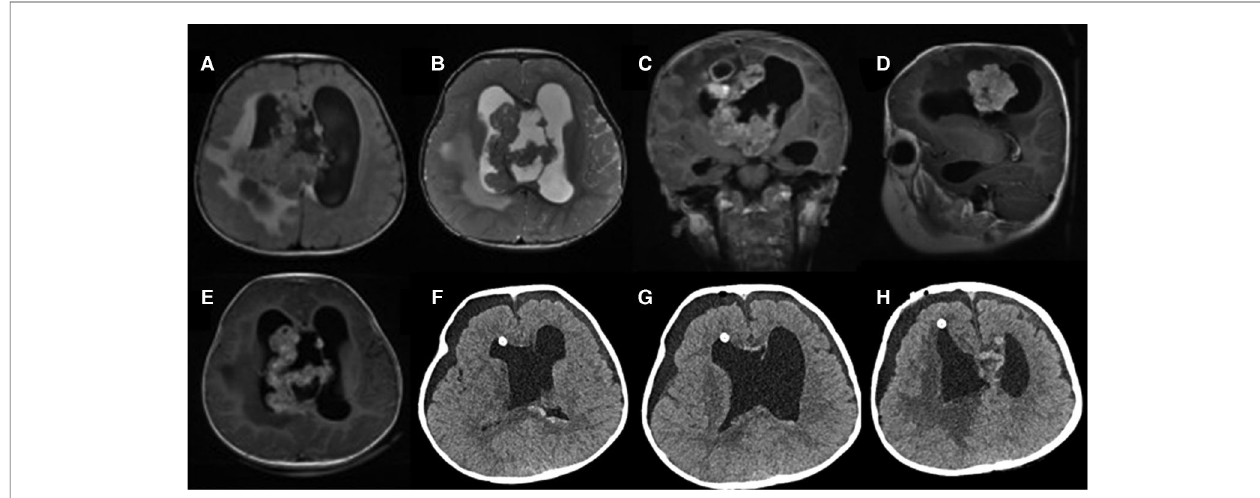
FIGURE 1 | Preoperative MRI: ( A ) axial T1 image; ( B ) axial T2 image; ( C ) coronal T1-weighted image with gadolinium contrast; ( D ) sagittal T1-weighted image with gadolinium contrast; ( E ) axial T1-weighted image with gadolinium contrast; Postoperative CT: ( F – H ) axial